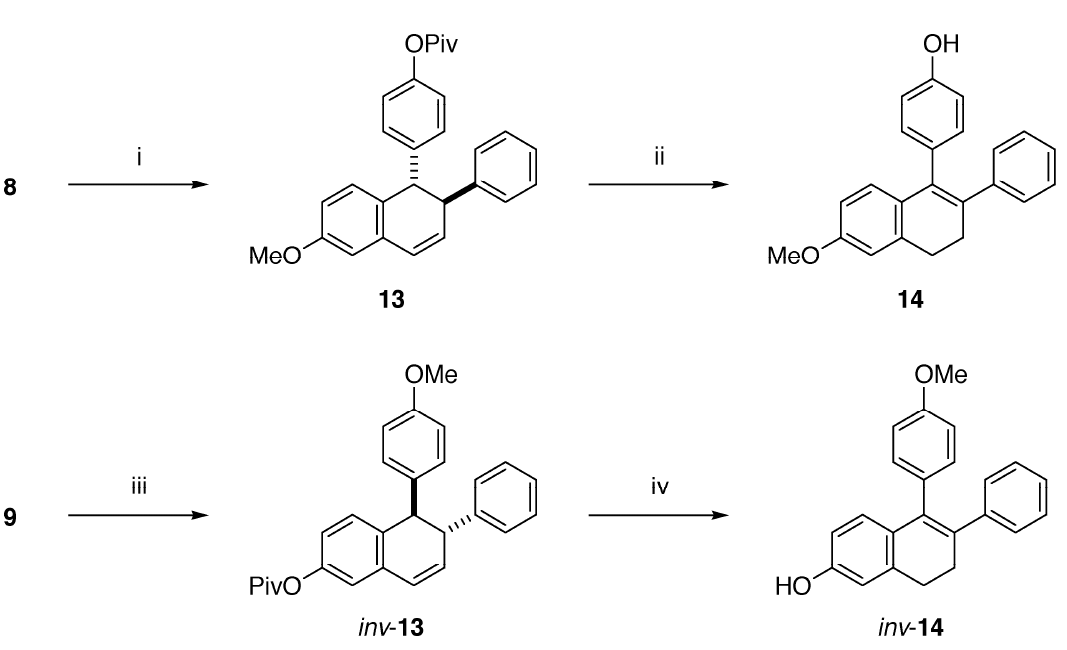
Scheme 6. Elimination of hydrogen iodide and double-bond migration